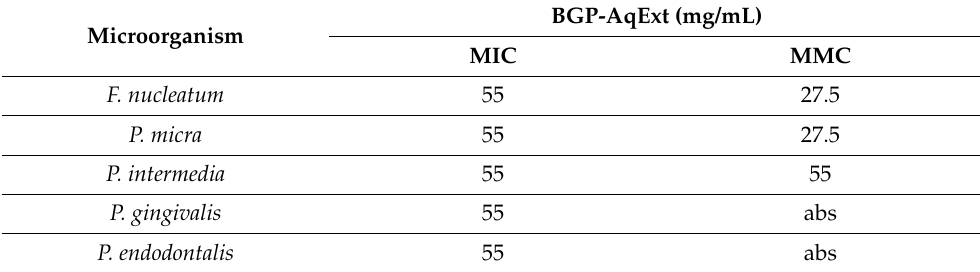
Table 2. MIC and MMC values of BGP-AqExt against the tested anaerobic